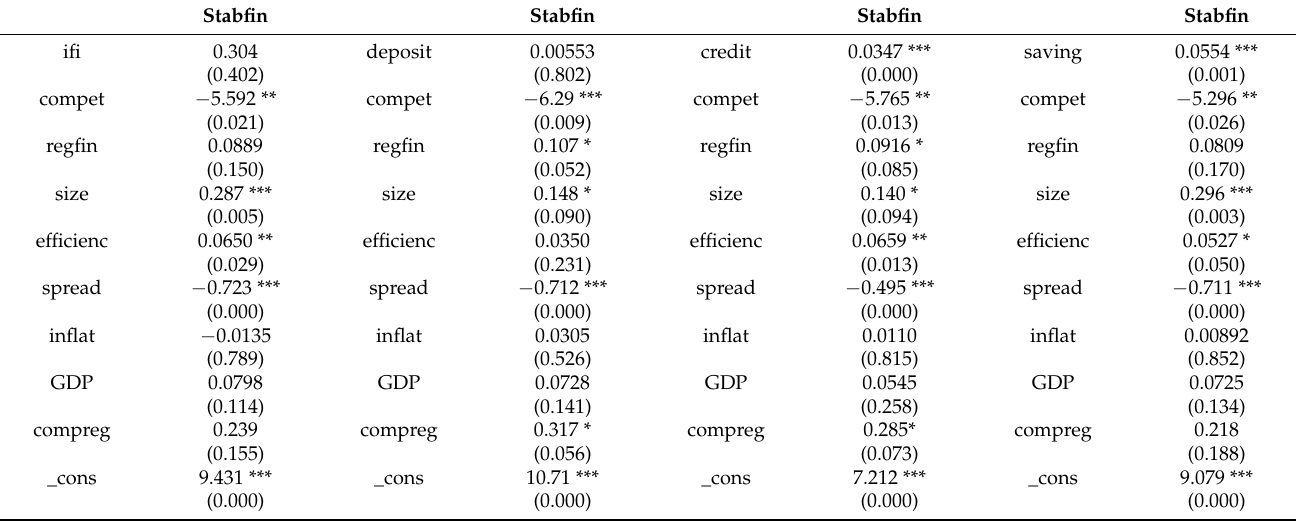
Table 10. The moderating role of financial regulation in SSA countries.